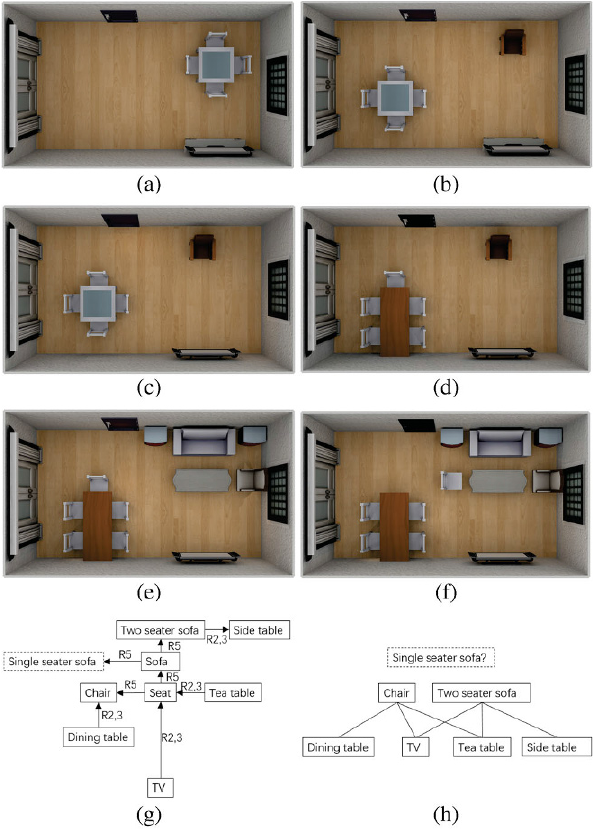
Fig. 5 An example of alternative room design showing several steps. (a) Original room design. (b) The user moves the table to the left half of the room. (c) The user changes the TV to a wall-mounted one. (d) The user changes the square table to a long table. (e) The user adds a coffee table in front of the TV. (f) We move a chair around the dining table. (g) Underlying knowledge graph for (e), with various entities and relations removed for clearer illustration. (h) Co-occurrence-based representation for (e) as commonly used in previous